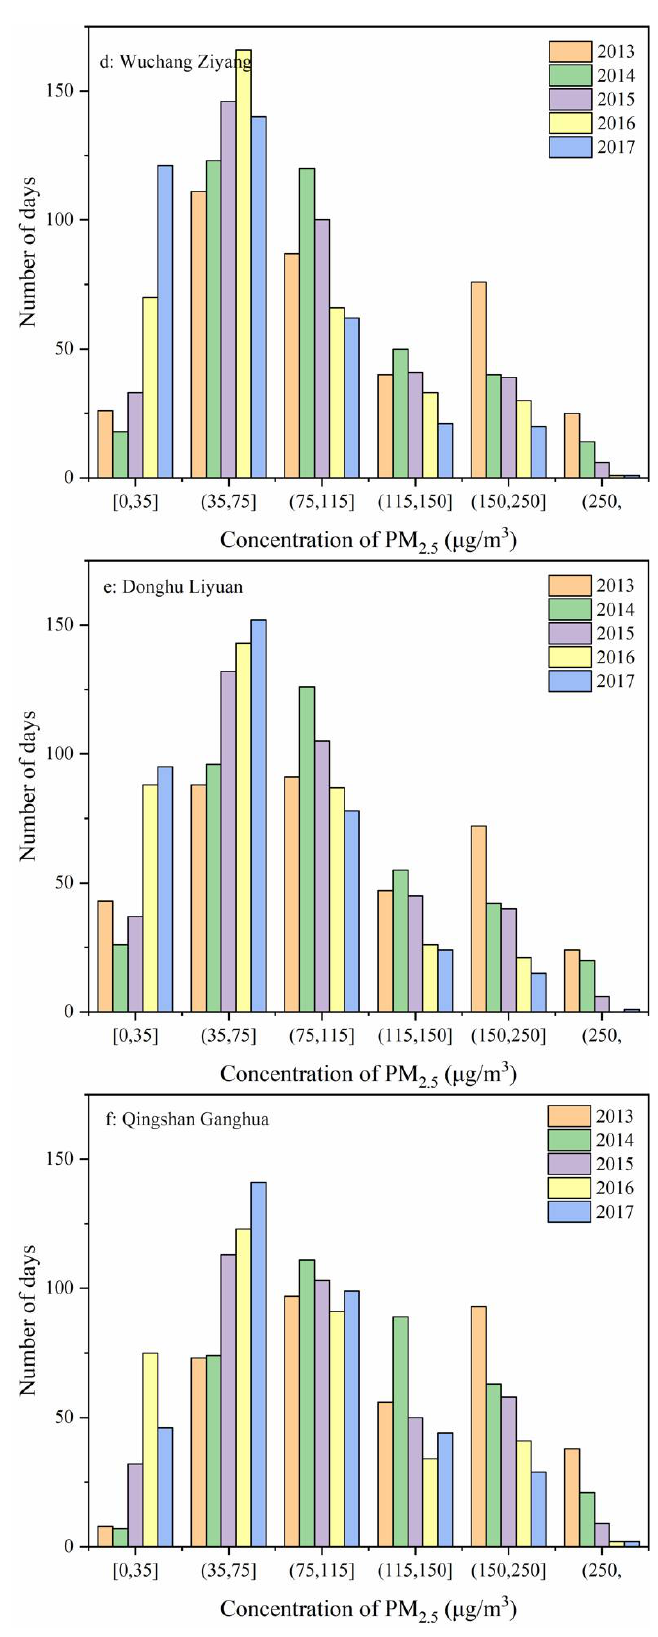
Figure 6. PM 2.5 distribution at various monitoring sites in the period of 2013–2017.